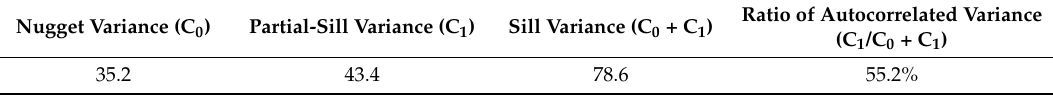
Table 2. Spatial statistics of pseudostem circumference in the plot under investigation.